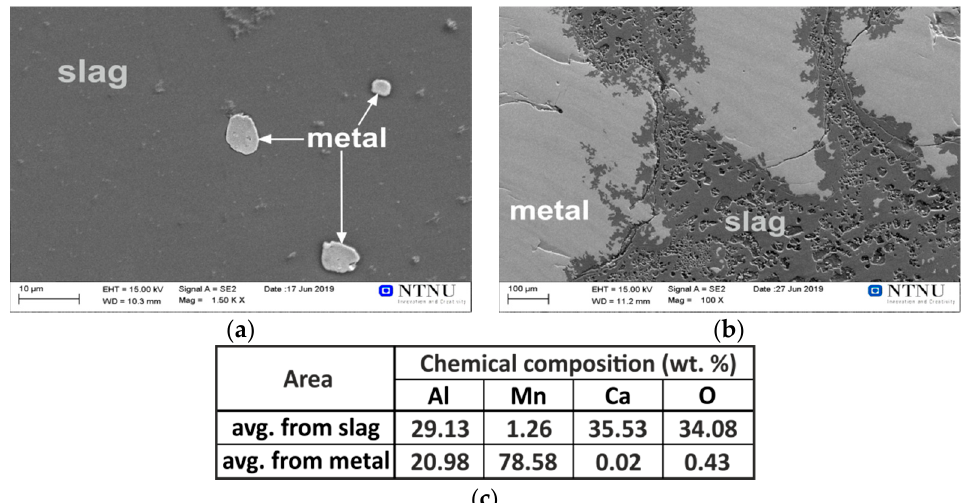
Figure 4. The SEM/EDS microstructural analysis of the cross-section of exp. 1 sample from slag area ( a ) and metal-slag contact area ( b ); EDS ( c ).